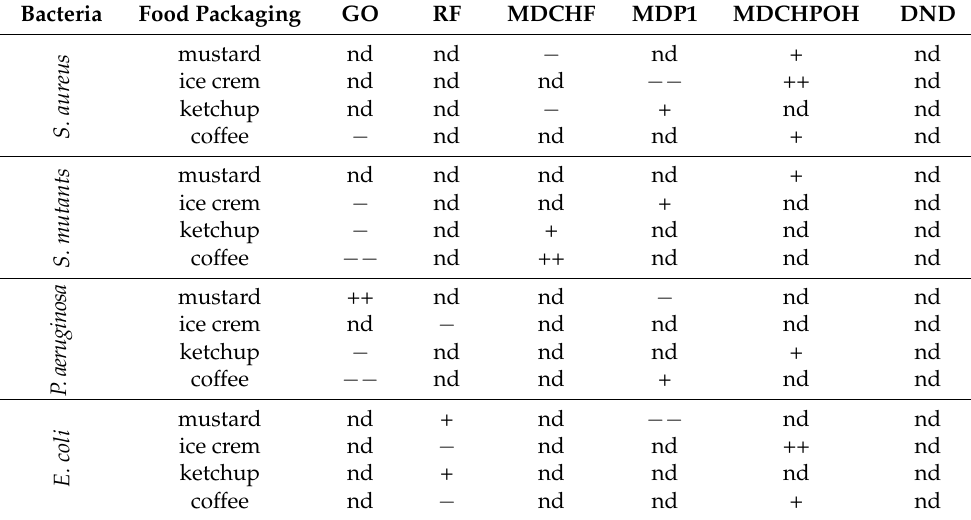
Table 1. The adhesion of bacteria for food films coated with carbon powders.